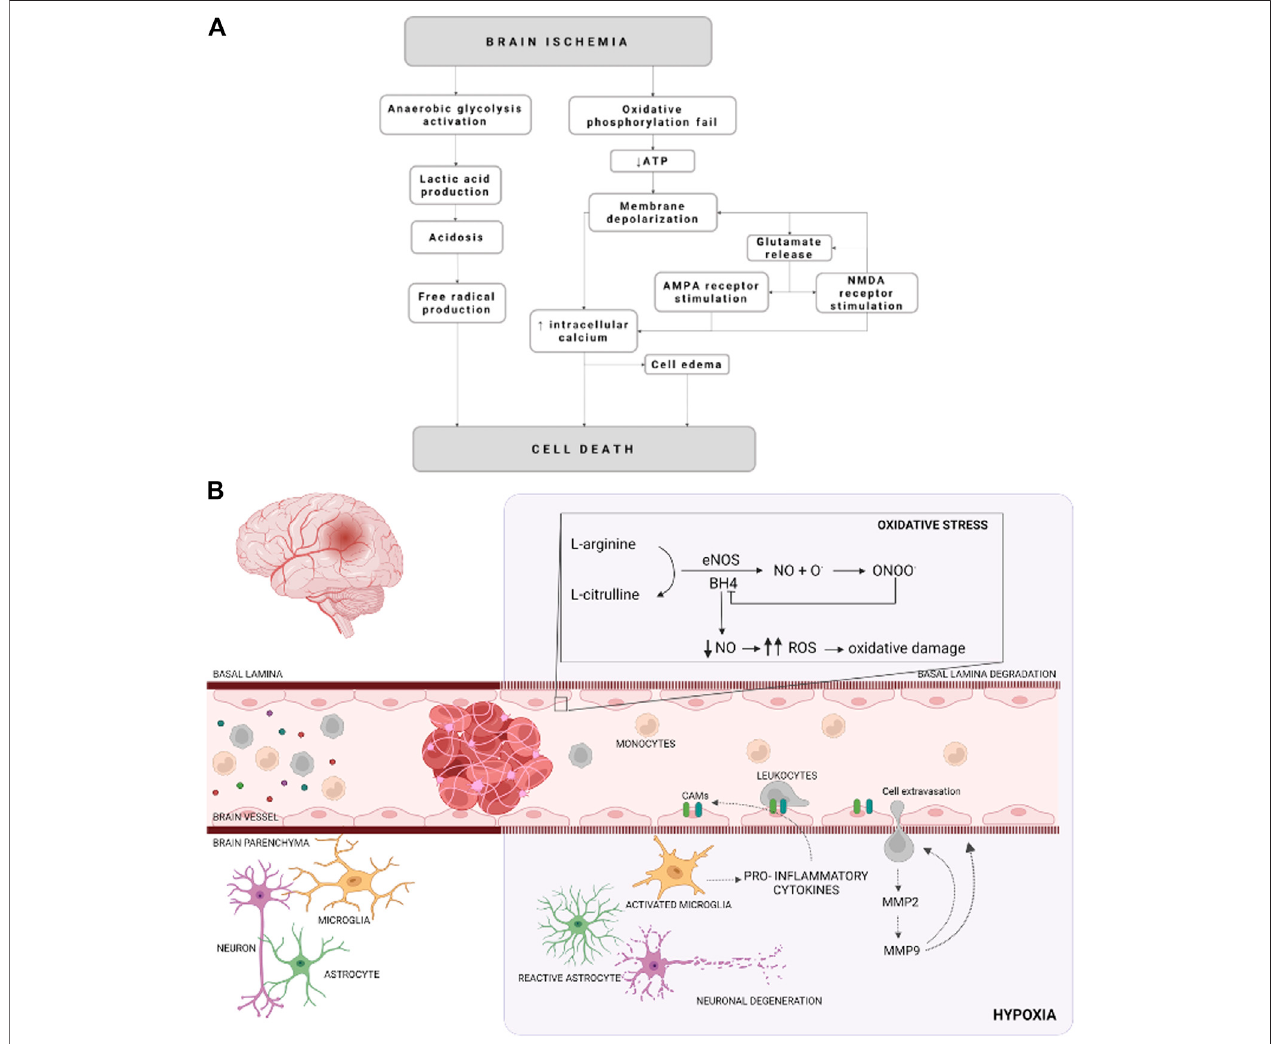
FIGURE 1 | Schematic representation of cellular mechanisms during an ischemic stroke. (A) Schematization of the molecular events that occurred due to an ischemic event. (B) Illustration of cellular and molecular events on cerebral ischemia. Cellular adhesion molecules (CAMs), reactive oxygen species (ROS), endothelial nitric oxide synthase (eNOS), nitric oxide (NO), metalloproteinase (MMP), tetrahidrobiopterine (BH4), oxygen radicals (O . ), and peroxynitrite (ONOO − ) are represented by their acronyms.